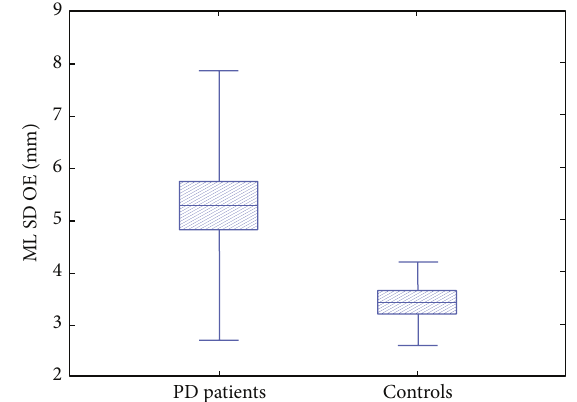
Figure 3: Mediolateral standard deviation of trunk sway with open eyes in PD patients with respect to controls. PD patients showed higher values of mediolateral (ML) standard deviation (SD) of trunk sway with open eyes (OE) with respect to